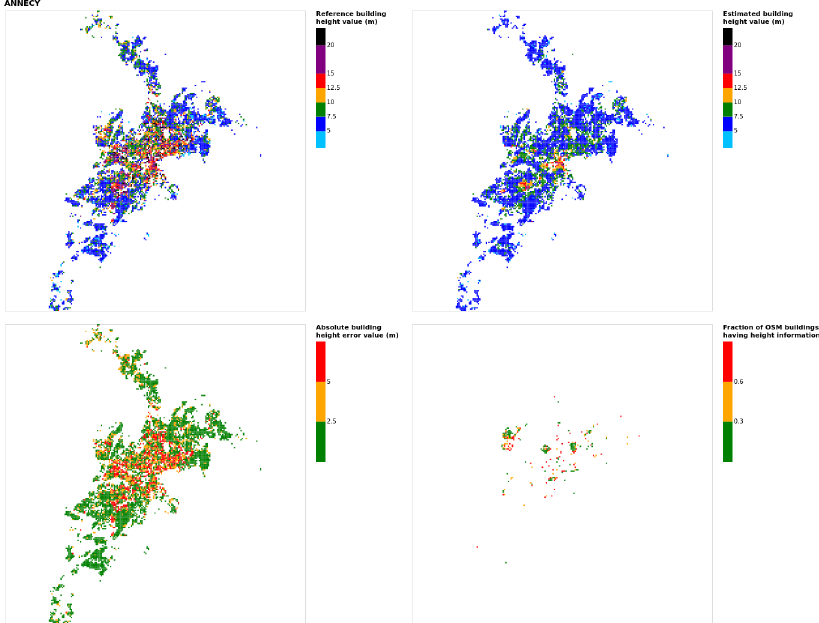
Figure B1. Results for the commune at grid cell (upper left panel) reference building height, (upper right panel) estimated building height, (lower left panel) absolute building height error, and (lower right panel) fraction of OSM buildings that have height information. For all panels except the lower right, only cells that have buildings – with at least 90% of their buildings having no height value in OSM – are displayed.